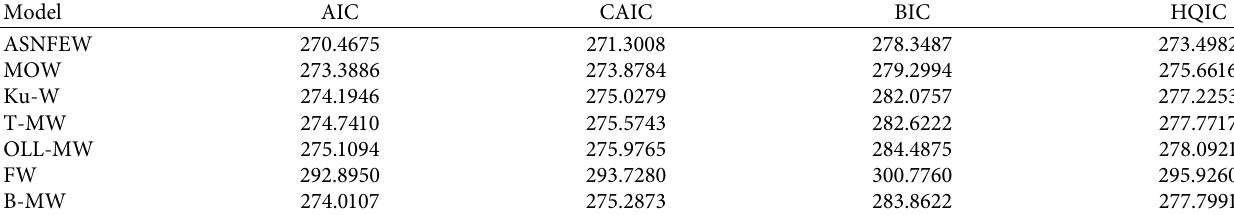
Table 5: DM of the competing models corresponding to COVID-19 data.